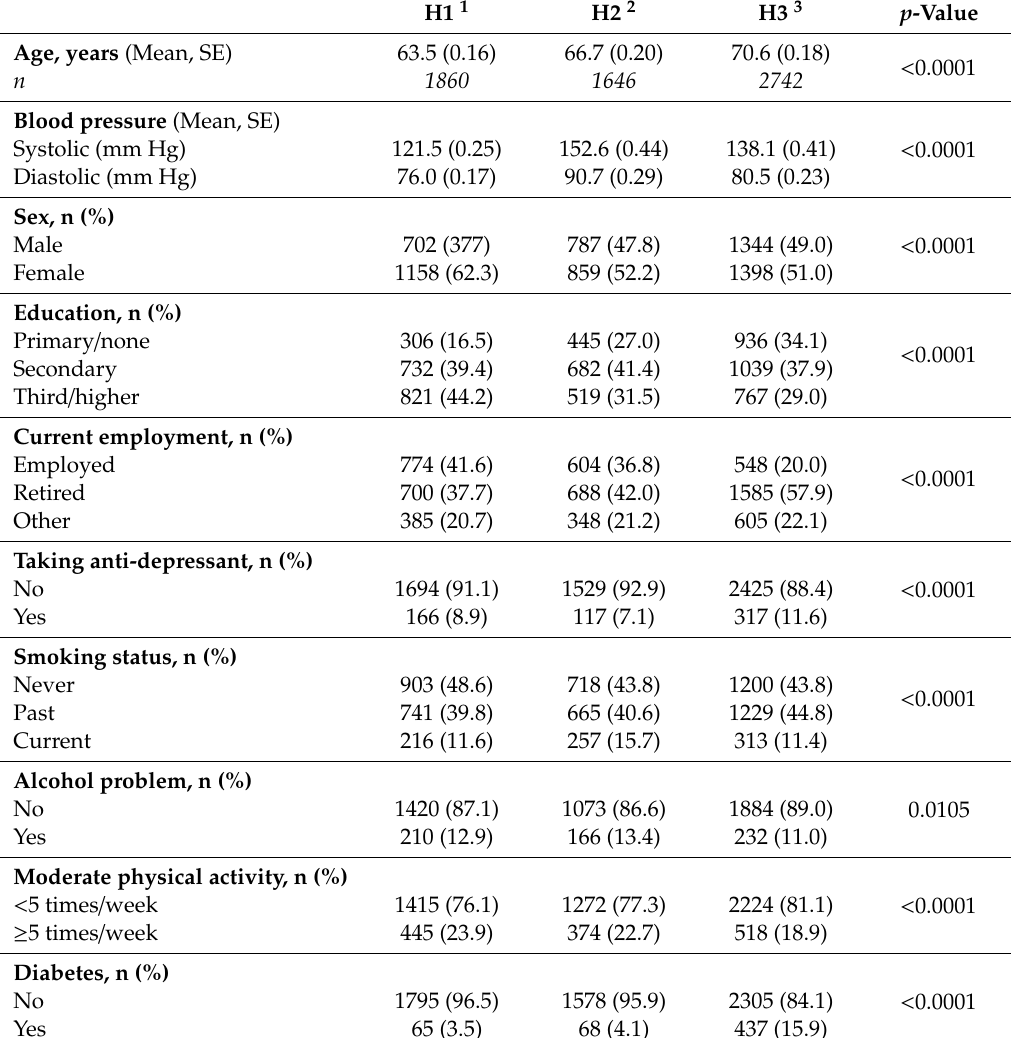
Table 2. Comparison of socio-demographic and health characteristics of participants at Wave 3 using analysis of variance